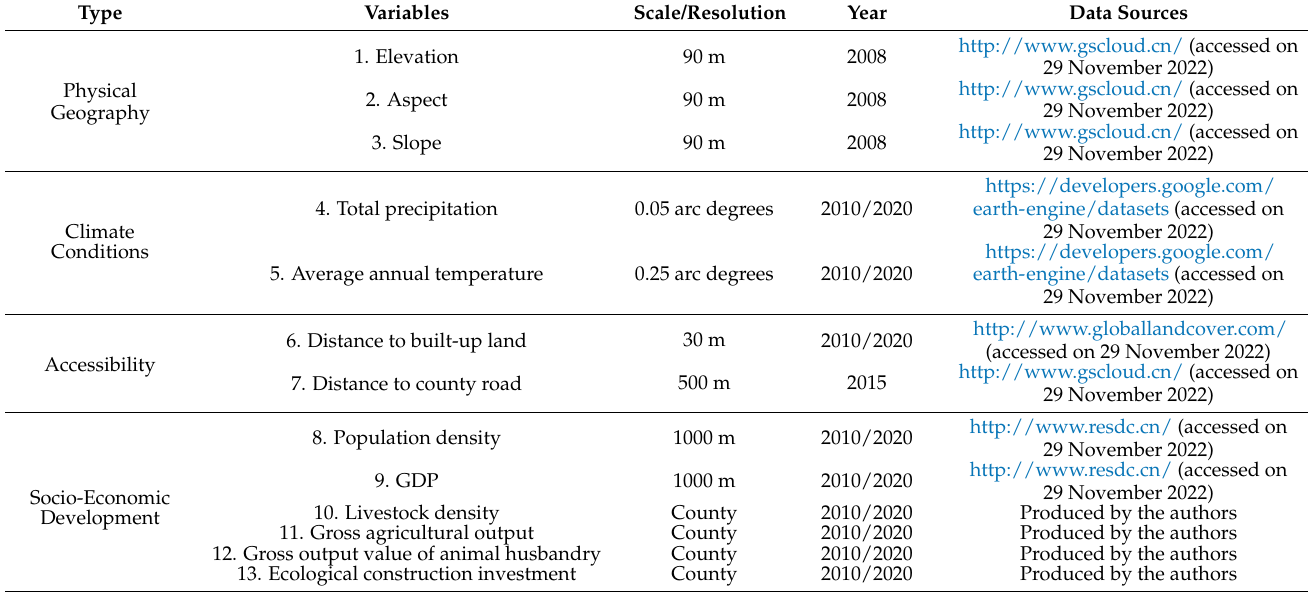
Table 2. Driving factors of LULC change in